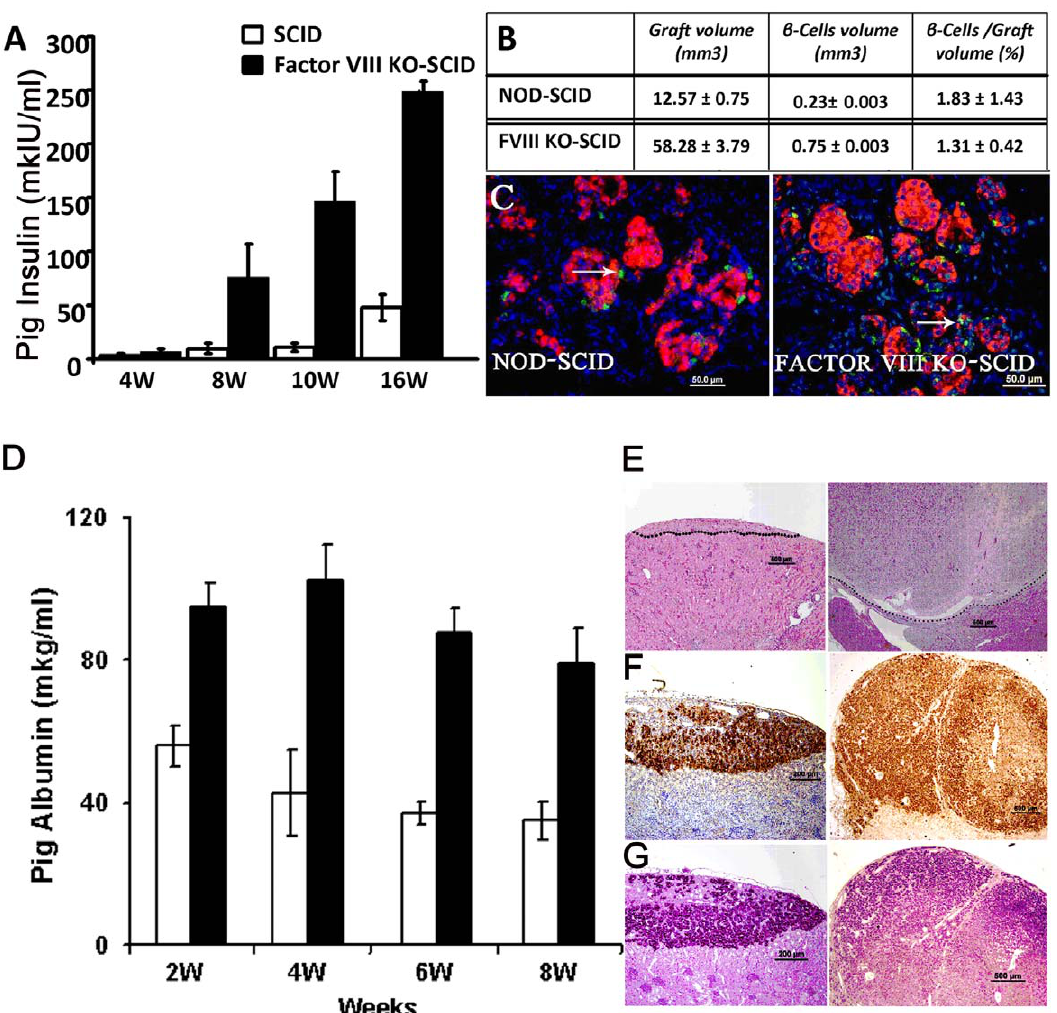
Figure 3. Enhancement of pancreas and liver size and function in Factor VIII KO- SCID mice. (A) Pig insulin serum levels following implantation of E42 pig pancreas into Factor VIII KO SCID and NOD-SCID mice. Data represent averages of four independent experiments (P , 0.005). (B) Morphometric analysis of E42 pancreas implants growth. Both recipients were evaluated for graft volume (left column) and beta cells volume (middle column) for pig insulin positive beta cell volume (right column), 3 months after transplantation (n=5). The specific difference in volume was not associated with a significant increase in b cell number. (C) Normal histological findings following E42 pig pancreas transplantation under the kidney capsule of NOD-SCID and Factor VIII KO-SCID mice. Pig insulin appears red, while glucagon is stained green. (D) Pig albumin serum levels following implantation of E42 pig liver precursor tissue into Factor VIII KO SCID and NOD-SCID mice. Data represent three independent experiments (P , 0.05). Illustration of increased growth and retained functionality of the liver grafts in Factor FIII KO-SCID recipient, demonstrated by H&E staining (E), and immunohistological staining of pig albumin (F), and PAS (G).